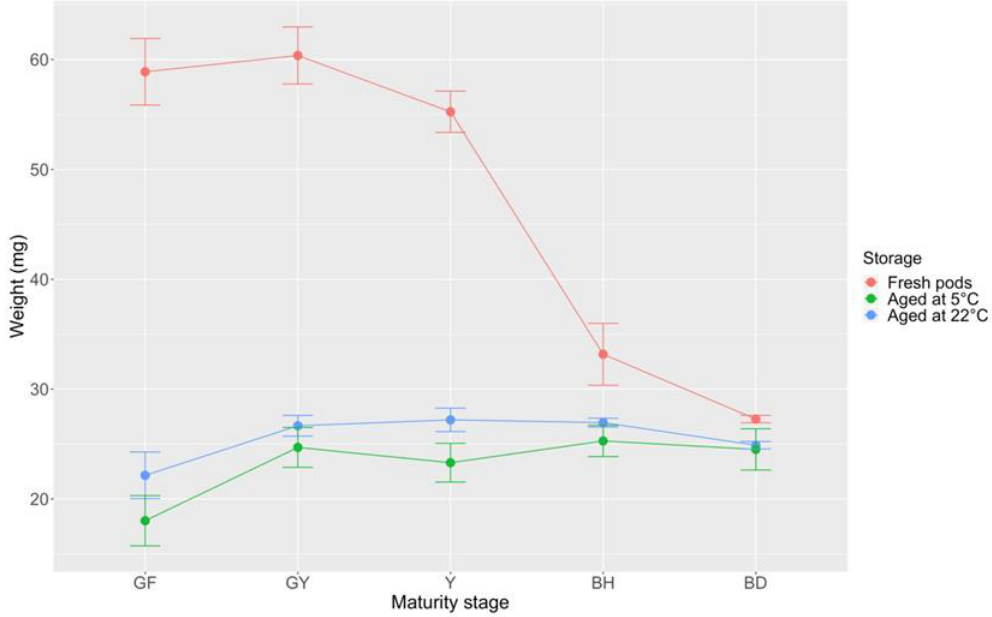
Figure 10. Mass of B. bituminosa fresh and stored pods at different maturity stages (420 days at 5 ± 1 °C and 22 ± 2 °C). Vertical bars represent standard errors. GF = green full; GY = green yellow; Y = yellow; BH = brown hydrated; BD = brown dehydrated.